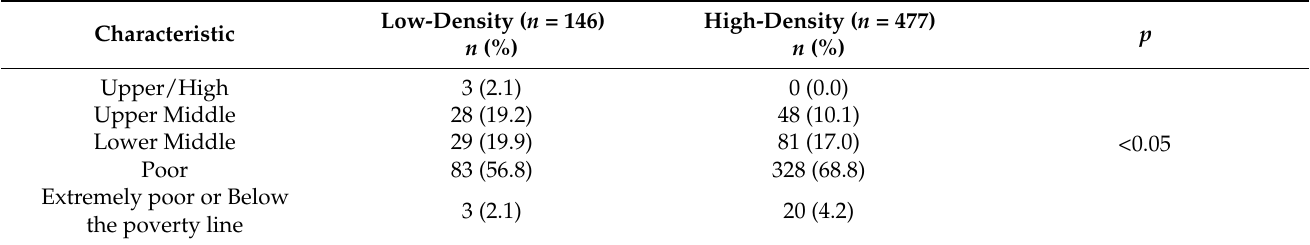
Table 3. Distribution of SES among neighborhood contacts in low-density and high-density areas.